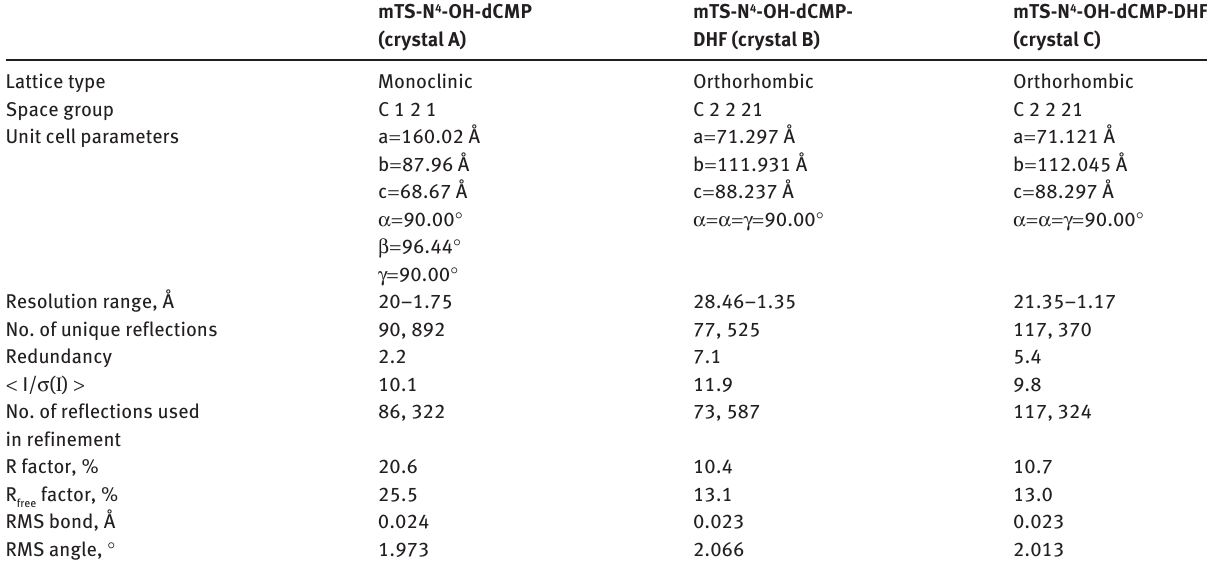
Table 1 Data collection and refinement statistics for mTS-N 4 -OH-dCMP (crystal A) and mTS-N 4 -OH-dCMP-DHF (crystals B and C) structures.